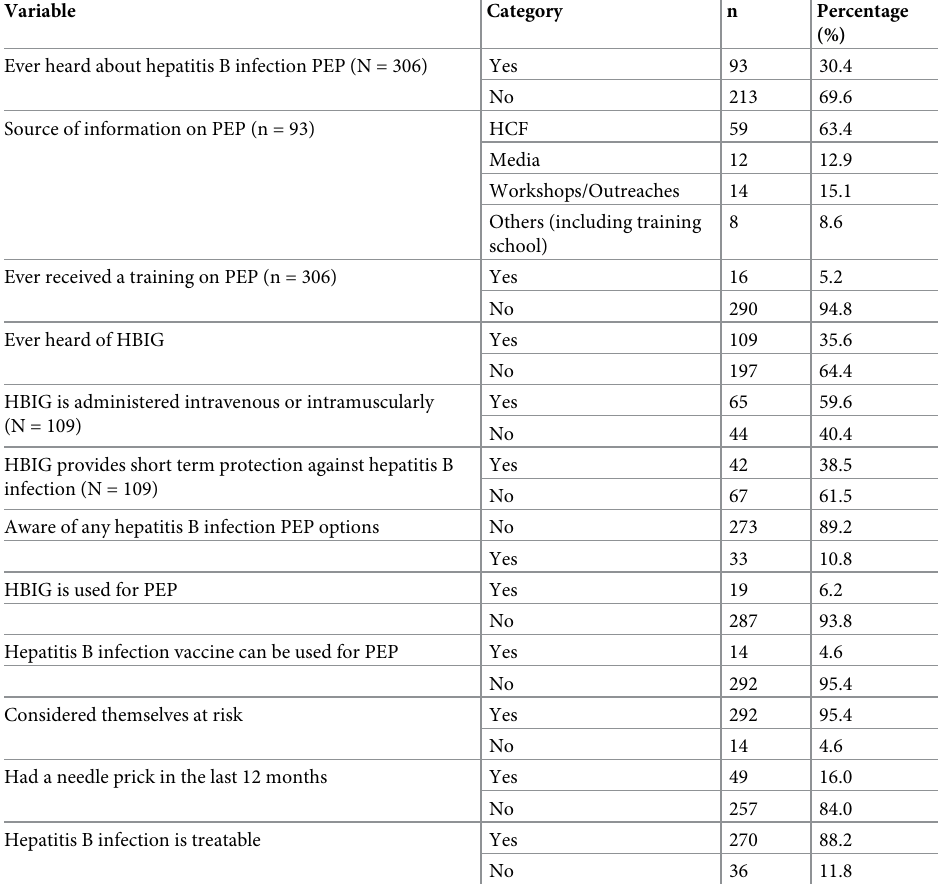
Table 3. Awareness of hepatitis B infection post-exposure prophylaxis among healthcare providers in Wakiso dis- trict,